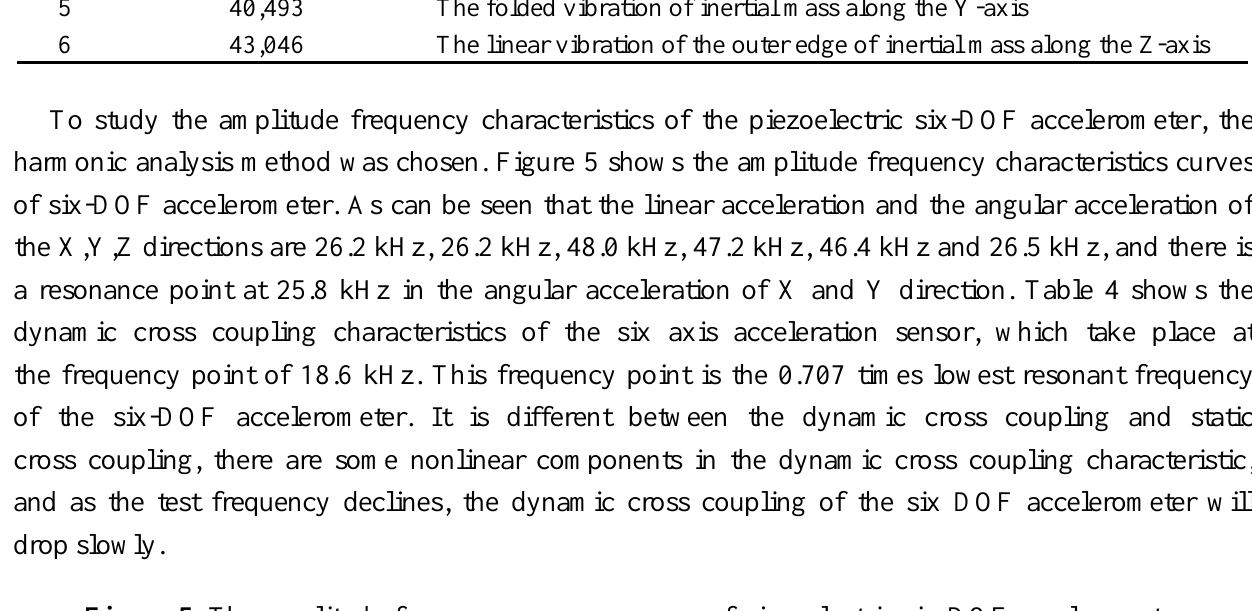
Figure 5. The amplitude-frequency response curve of piezoelectric six-DOF accelerometer. ( a ) X-axis linear acceleration; ( b ) Y-axis linear acceleration; ( c ) Z-axis linear